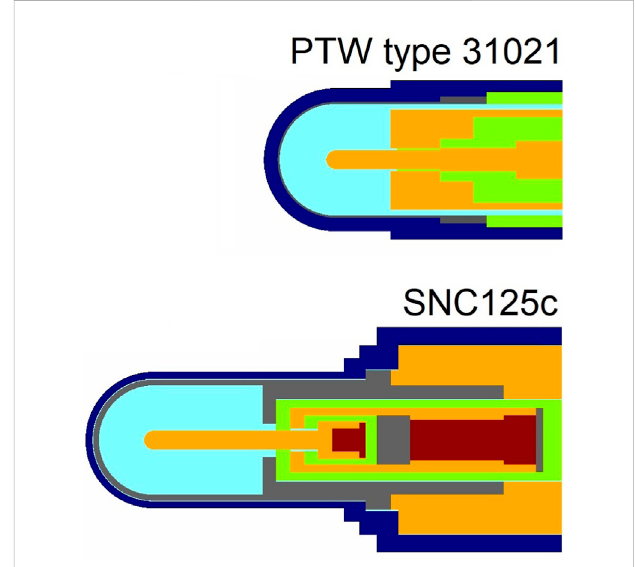
FIGURE 3 Cross sections of the investigated ionization chambers as used in this study (not to scale). The colors represent different